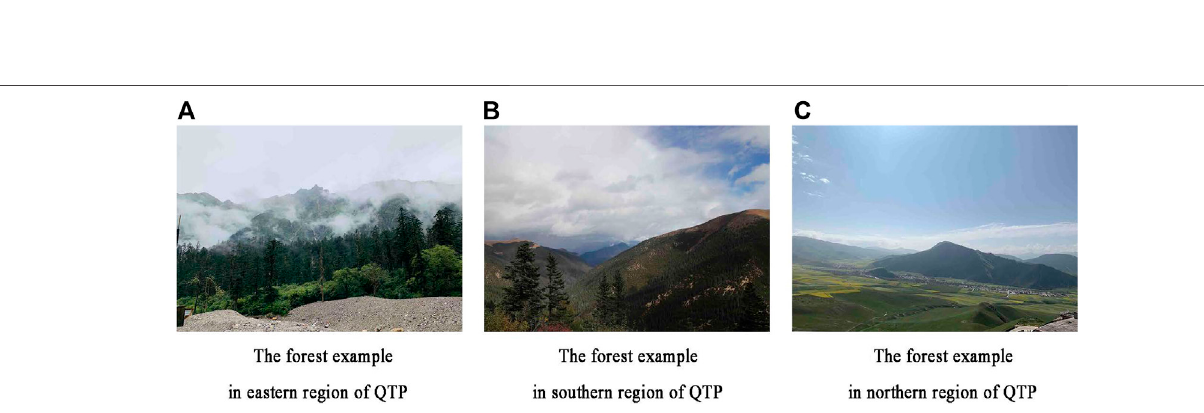
Frontiers in Environmental Science |